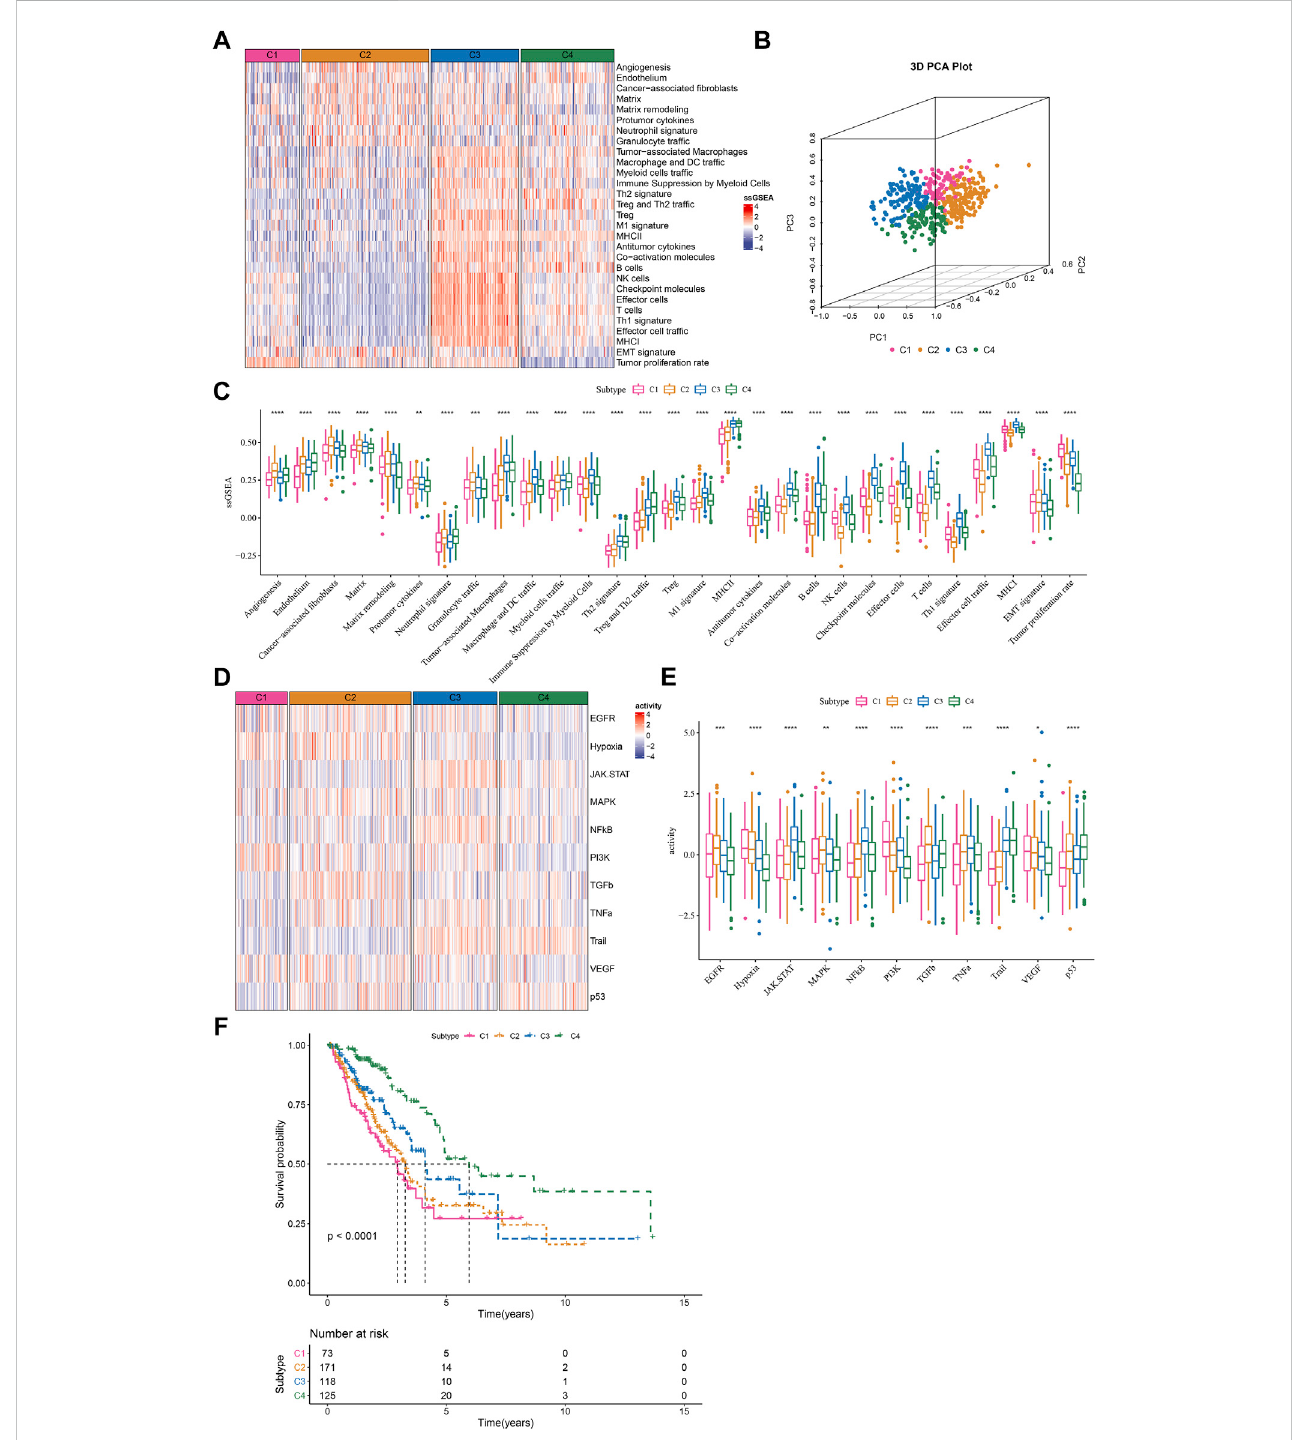
FIGURE 2 TheimmuneandpathwaydifferenceoffourTME-basedmolecularsubtypesinTCGAdataset (A) TheheatmapshowedtheenrichmentofTMEsignatures in four subtypes (B) 3D PCA plotof four subtypes based on TME signatures (C) The ssGSEA score of TME signatures infour subtypes (D) The heatmap showed the enrichment of oncogenic pathways in four subtypes (E) The ssGSEA score of oncogenic pathways in four subtypes (F) Kaplan-Meier survival plot of